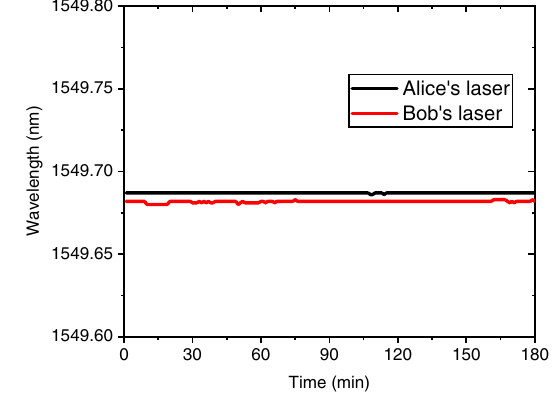
FIG. 5. Observed wavelength of laser pulses at each user over